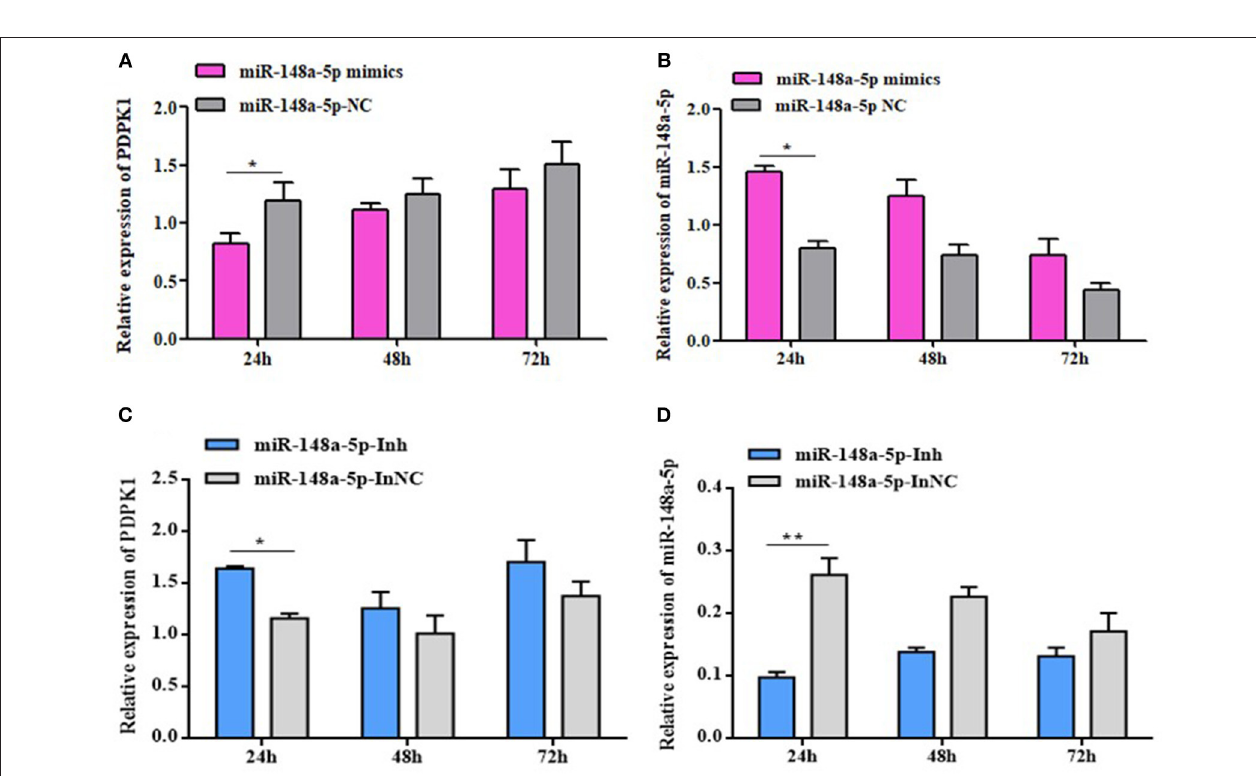
FIGURE 6 | gga-miR-148a-5p regulates PDPK1 expression. (A) The expression level of PDPK1 in CEF cells overexpression gga-miR-148a-5p is reduced. (B) The expression level of gga-miR-148a-5p in CEF cells overexpression gga-miR-148a-5p is increased. (C) Transfection with gga-miR-148a-5p inhibitor increased the mRNA expression of PDPK1 in CEF cells. (D) Transfection with gga-miR-148a-5p inhibitor decreased the mRNA expression of gga-miR-148a-5p in CEF cells. All of the error bars represent the means ± SEM of triplicated experiments. One-way ANOVA was used to analyze the significant differences. * P < 0.05; ** P <